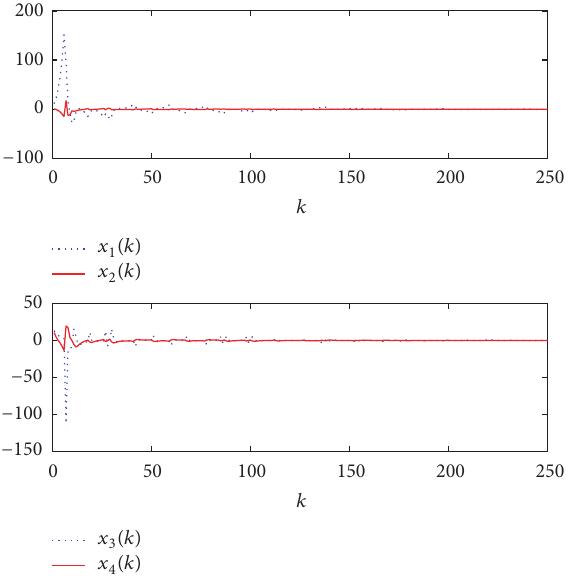
Figure 7: Asymptotic convergence of the system when 𝑁 = 60 under method